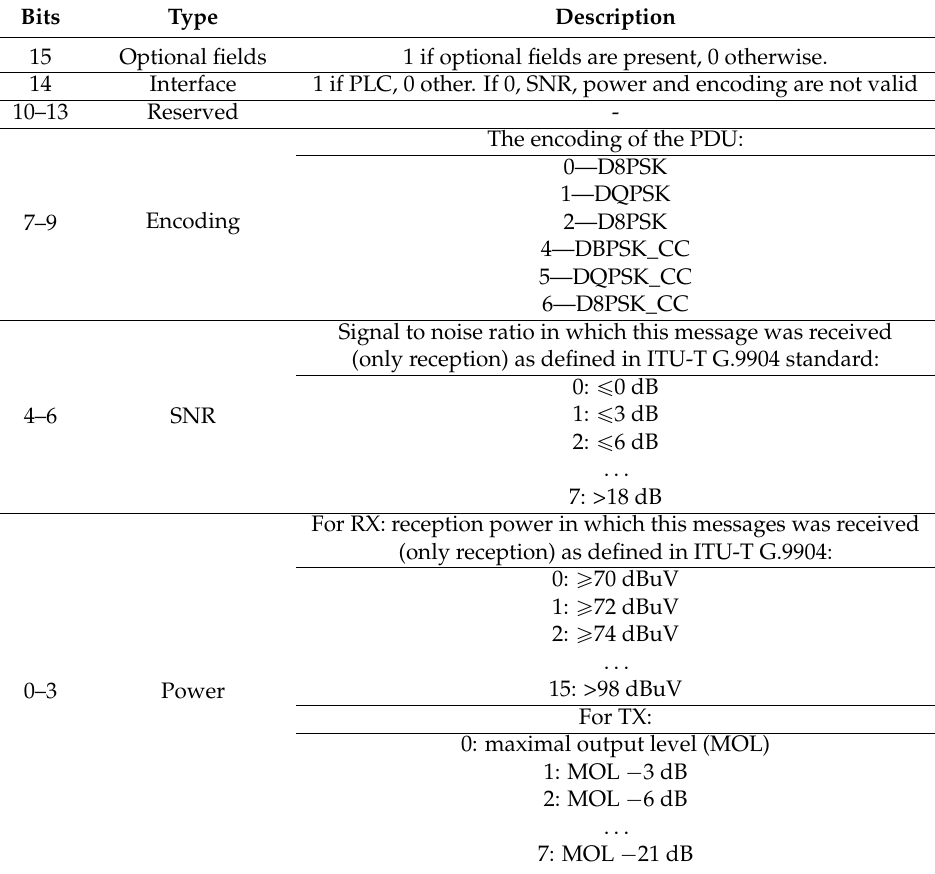
Table 5. Traffic capture interface protocol. Payload physical layer (PHY) Info format. Bits Type